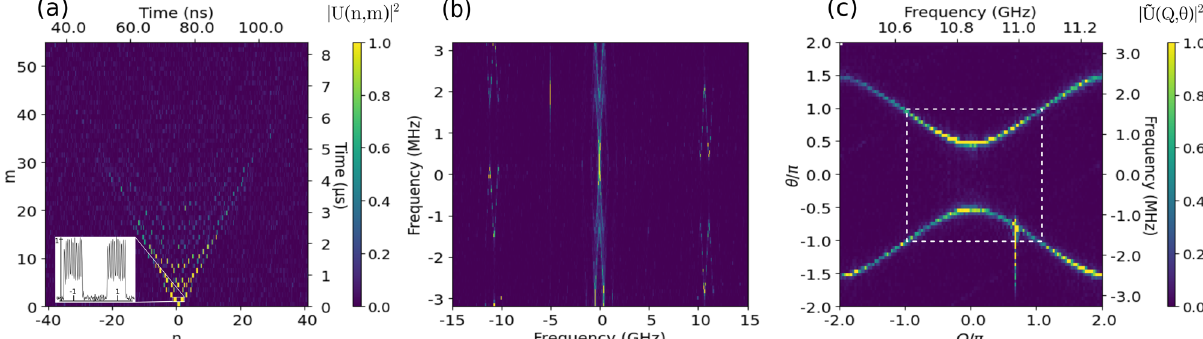
Fig. 2 Experimental results. The space – time evolution shown in ( a ) is measured in the U loop when a short pulse is injected in the V loop. The impulse response of the lattice shown in ( a ) is beaten against a reference laser fi eld. This gives square pulses being modulated at ~10.8 GHz, as shown by the inset in ( a ). The fringe pattern expanding in space ( n ) and time ( m ) is numerically Fourier transformed in the two dimensions. This gives the 2D Fourier power spectrum plotted in ( b ) with one central component and two weak side bands at ~±10.8 GHz. The 2D Fourier spectrum plotted in ( c ) represents a zoomed view of the spectrum shown in ( b ) between 10.45 and 11.33 GHz. In terms of normalized units ("Bloch momentum ” Q and “ quasi-energy ” θ ), the photonic band structure of the lattice is measured for Q ∈ [ − 2 π , 2 π ], θ ∈ [ − 2 π , 2 π ]. The fi rst Brillouin zone is depicted by the square region plotted in ( c ) with white dashed lines. The vertical color bar indicates the mapping from the normalized spectral power j ~ U ð Q ; θ Þj 2 to Measurement of the photonic band structure . Our experimental the wave fi eld at the output of the double loop system is beaten determination of the band structure characterizing a Floquet – against a reference fi eld, which is detuned from the frequency of Bloch lattice is based on the single-shot simultaneous measure- the wave fi eld by ~10.8 GHz. ment of the phase and amplitude of the impulse response of the As shown in Fig. 1a, a single-frequency laser at 1550 nm is split lattice. This is achieved using a heterodyne measurement where into two arms by using a 99/1 fi ber coupler. The high-intensity